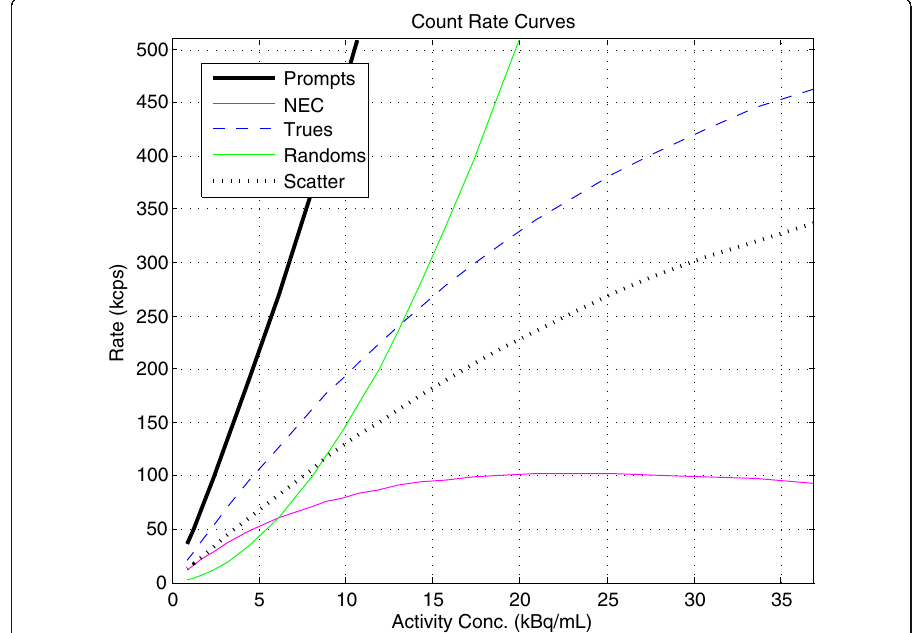
Fig. 2 Decay series — count rates as a function of activity concentration. Prompts, trues, randoms, scatters and NECR are depicted as a function of activity concentration. Peak NECR is 102.3 kcps at activity concentration of 23.0 kBq/cc. The peak true counting rate on the MI 3 was 463.1 kcps at 36.9 kBq/ml. NEC noise equivalent